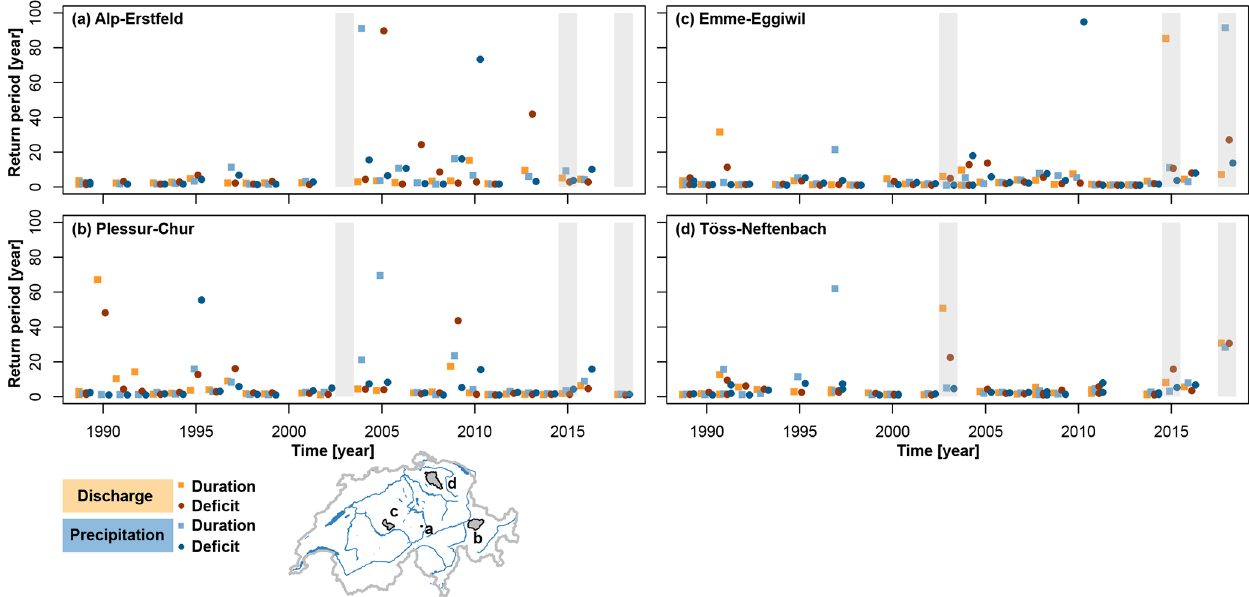
Figure 5. Univariate return periods of the extracted events within the period 1989–2018 for the alpine catchments Alp–Erstfeld (a) and Plessur–Chur (b) and for the catchments Emme–Eggiwil (c) in the Swiss Prealps, and Töss–Neftenbach (d) in the Swiss Plateau region, in terms of discharge deficit duration (orange squares), discharge deficit (red circles), precipitation deficit duration (blue squares), and precipitation deficit (blue circles). The grey polygons indicate the events in 2003, 2015, and